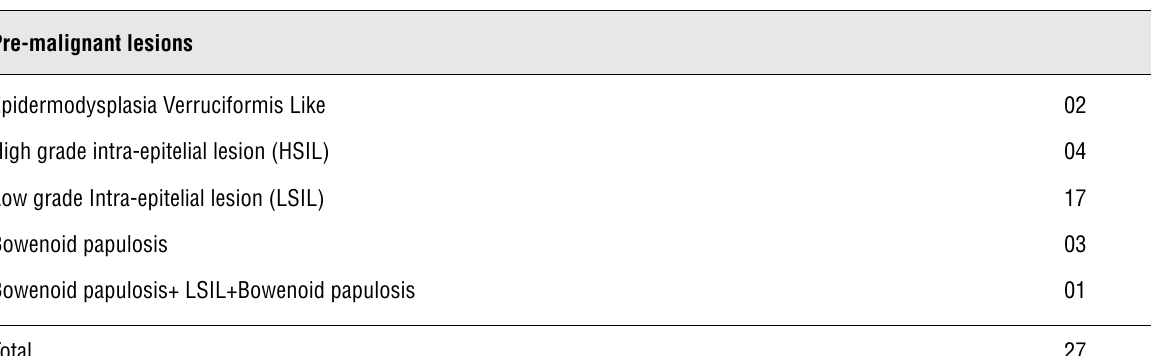
Table 6 – Distribution of histopathological findings of 27 pre-malignant lesions. Pre-malignant lesions Epidermodysplasia Verruciformis